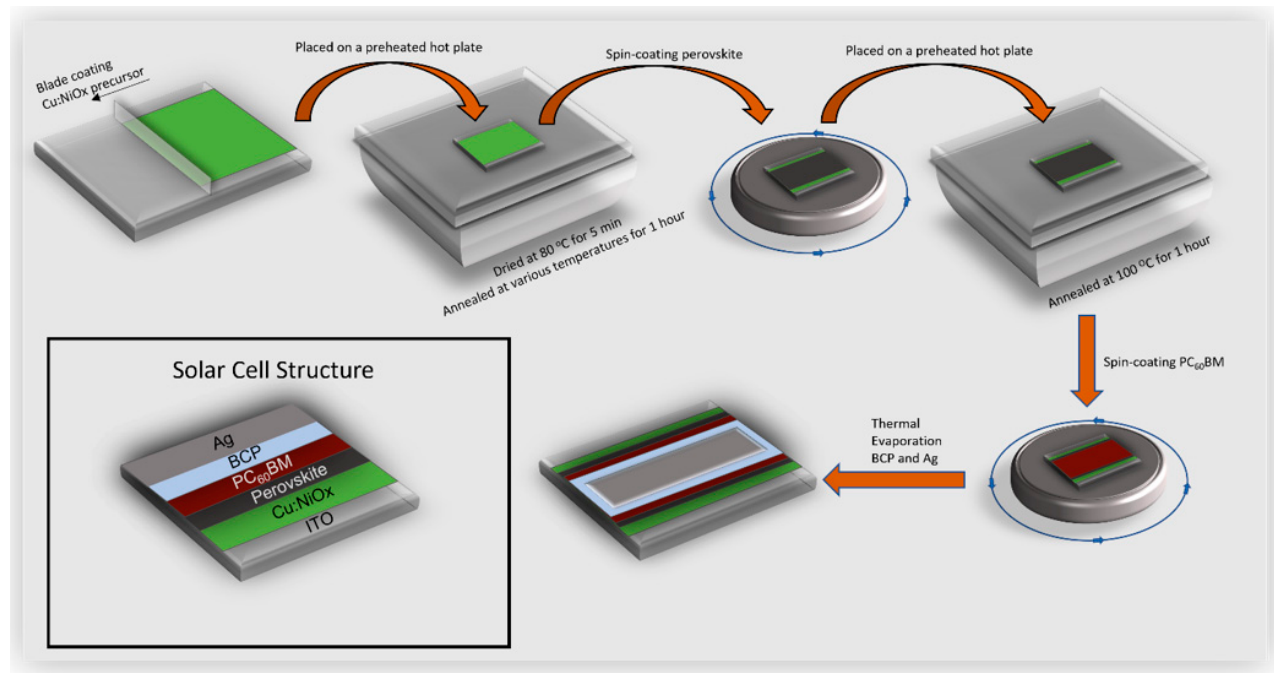
Figure 1. Schematic illustration of SCS based Cu:NiOx HTL and perovskite device fabrication process and the layer structuring .